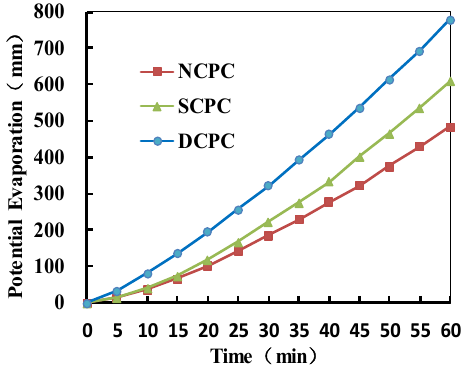
Figure 5. Evaporation force variation.